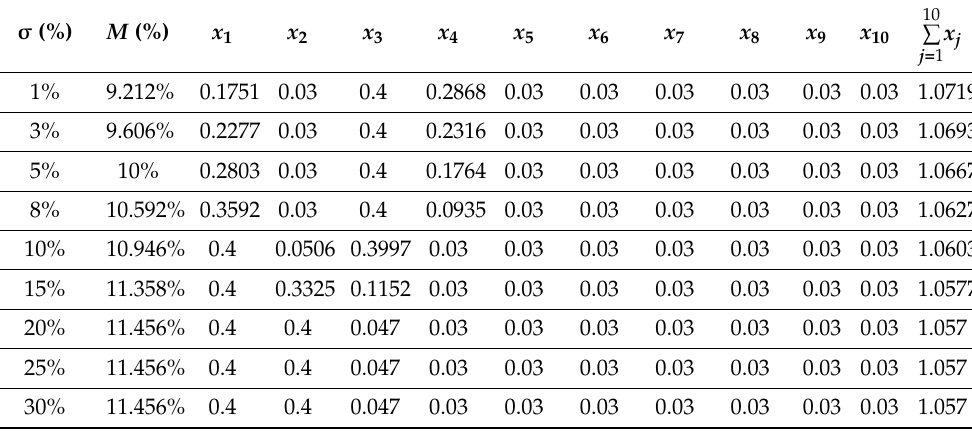
Table 8. The possibilistic efficient portfolios with b = 0.2, p 1 = 0.3, p 2 = 0.2, p 3 =